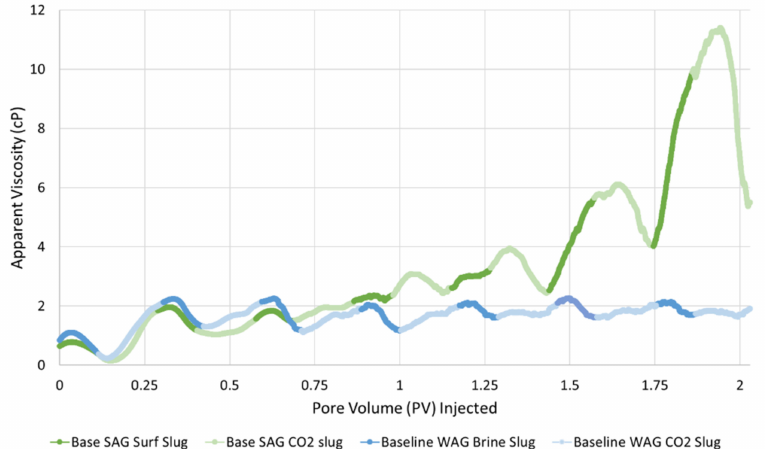
Figure 7. The first seven cycles for the Baseline WAG (blue curve) and Base SAG (green curve) experiments. Surfactant, or water, slugs are indicated with darker colors whereas the CO2 slugs are lighter colored. The maximum apparent viscosity value of WAG is indicated with the dotted red